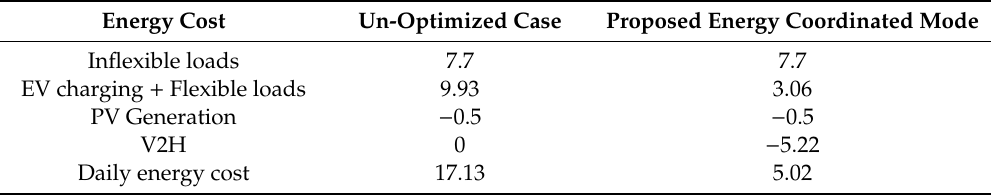
Table 1. Energy Comparative Costs ($ / day) for a Typical